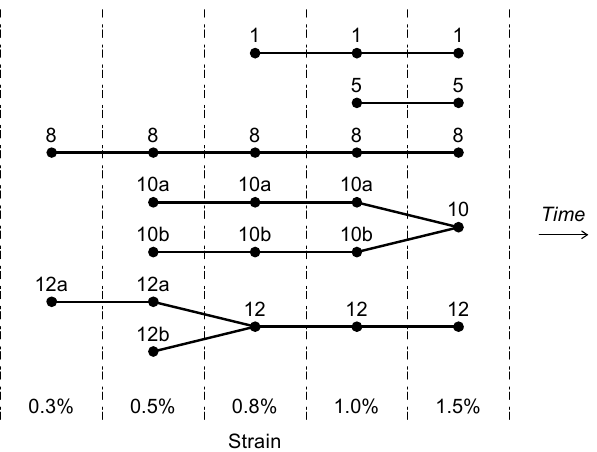
Figure 16. Computed crack genealogy trees for selected cracks in the sample shown in Figures 4 and 15. Each vertex represents a specific crack (sub-graph) in the final EG of the corresponding image. Two crack coalescence events are observed at 0.8% and 1.5% strain. Crack labels as depicted in related figures.